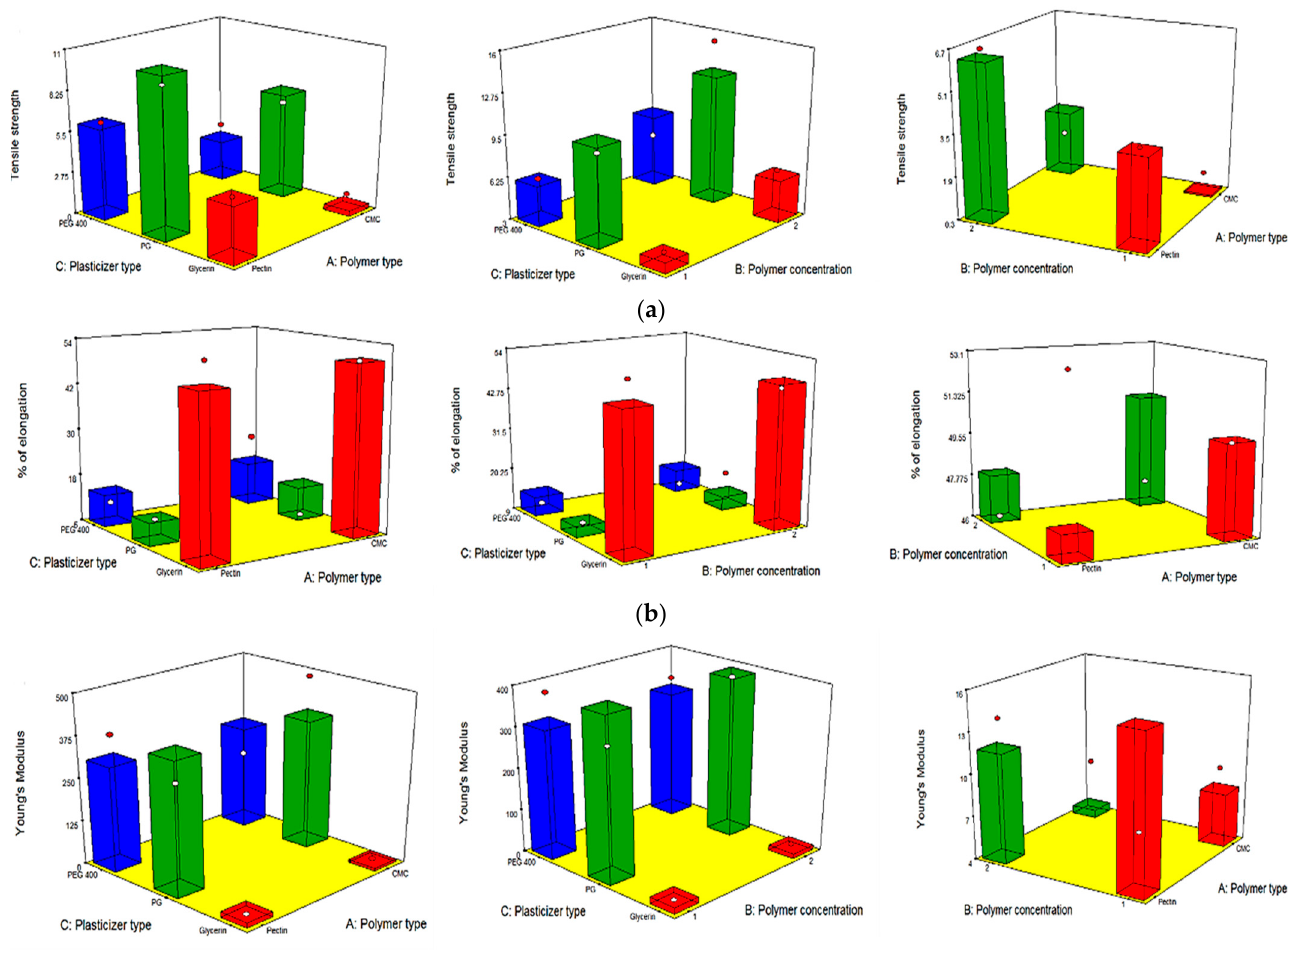
Figure 2. Response 3-D plots for the effect of polymer type (X 1 ), polymer concentration (X 2 ), and plasticizer type (X 3 ) on ( a ) tensile strength, ( b ) elongation %, and ( c ) Young’s modulus of the OFDFs loaded with PX nanosuspension.